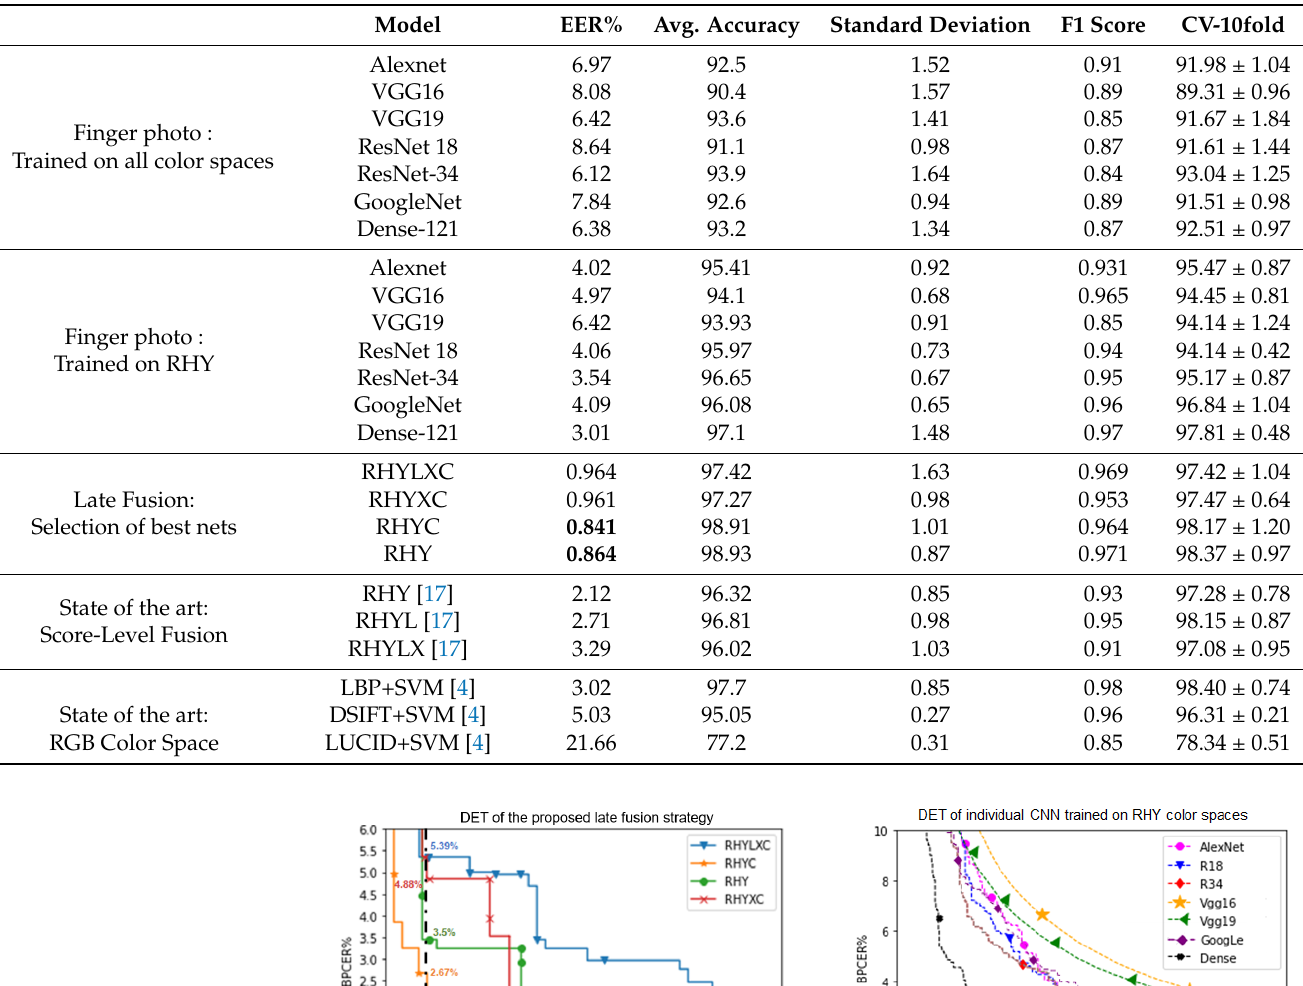
Table 4. Comparison of the Proposed Approach to the State-of-the-art in terms of EER%. Model